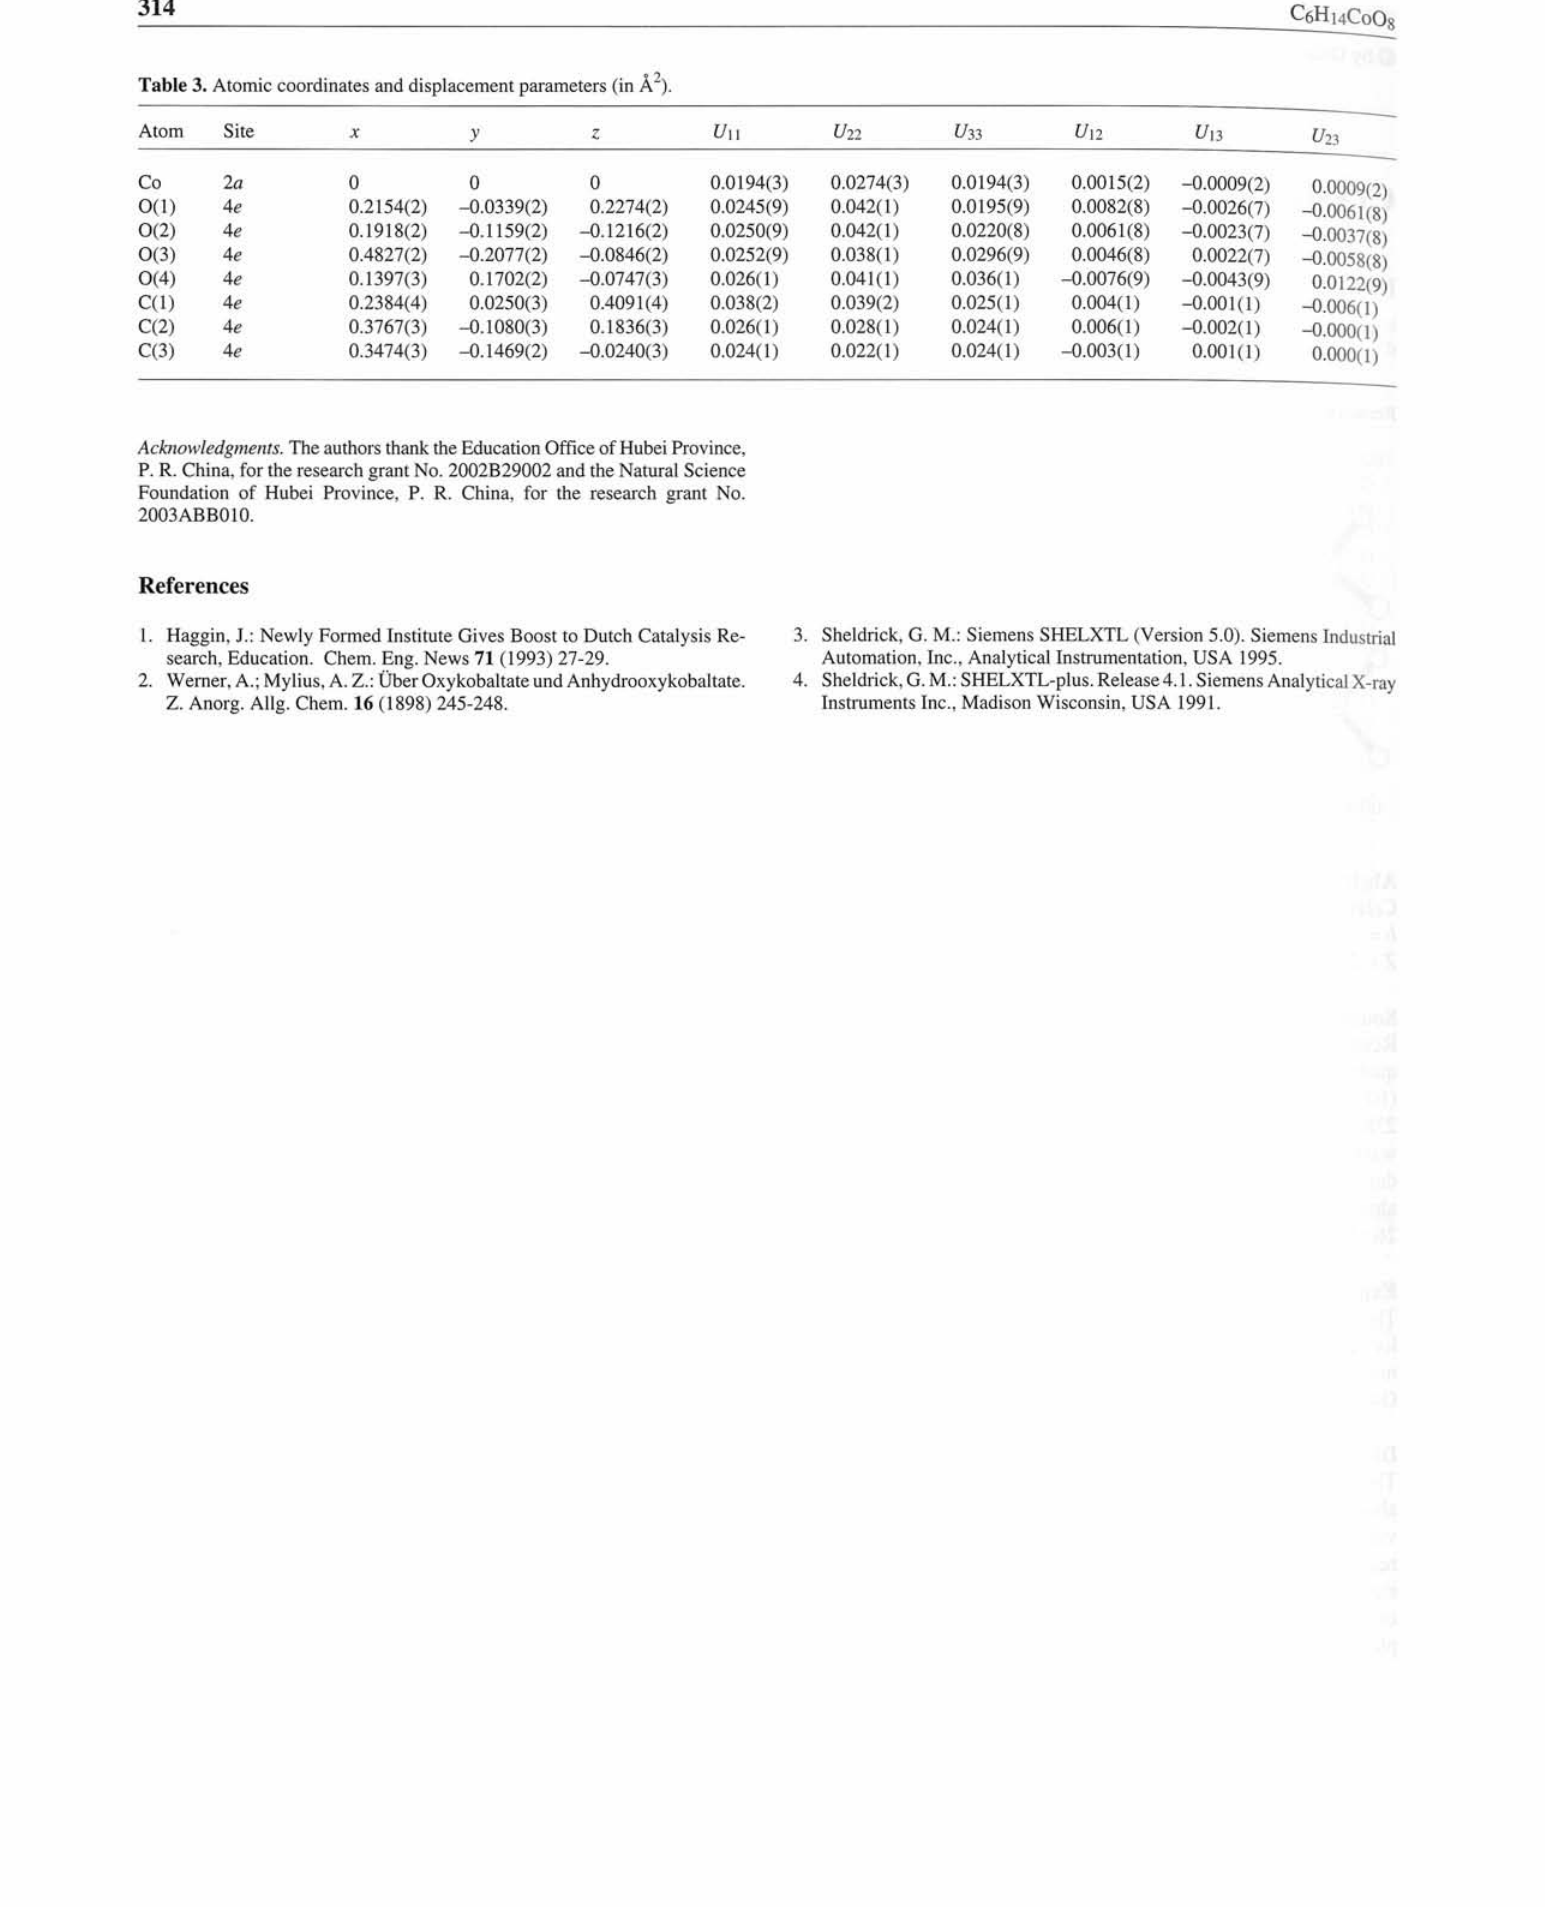
Table 3. Atomic coordinates and displacement parameters (in